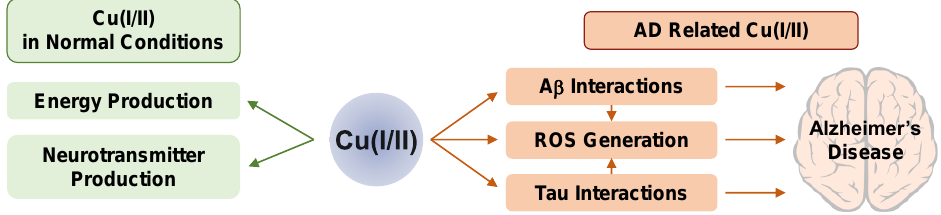
Figure 1. The roles and influence of Cu(I/II) on normal (left) and AD-affected (right) conditions.